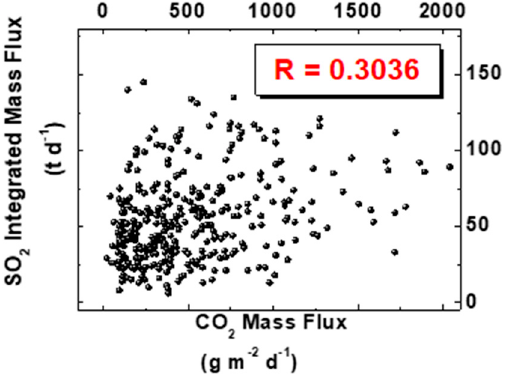
Figure 8. SO 2 and CO 2 trend over time.